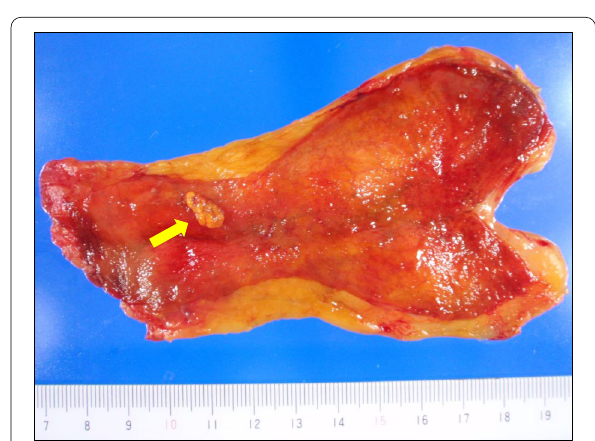
Fig. 3 Examination of the resected specimen revealed a